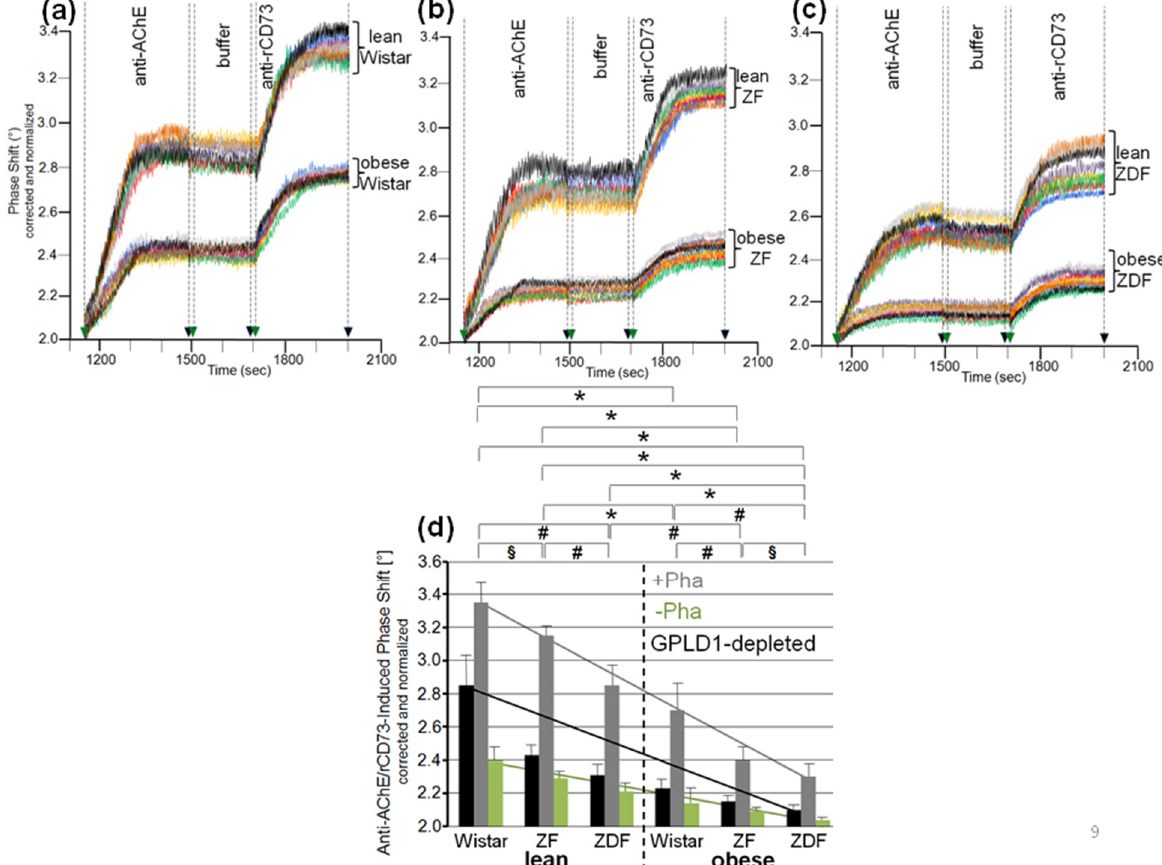
Figure 9. Differential inhibition of translocation of bAChE from micelle-like complexes to rat adipocytes by serum from metabolically deranged rats. The experiment was performed as described for Figure 8 with initial incubation (180 min) of isolated rat adipocytes with micelle-like bAChE complexes (20 volume equivalents) and serum (5 volume equivalents) that had been left untreated in the presence of Pha ( a – d ) or its absence (only d ), or that had been depleted of GPLD1 in the presence of Pha (only d ). ( a – c ) Phase shift is shown only for the injection of anti-AChE and anti-rCD73 antibodies (between 1150 and 2000 s). Each comparison was performed with the same chip and repeated three times (different preparations of micelle-like bAChE complexes) with similar results (representatives shown). ( d ) The anti-AChE and rCD73 antibody-induced phase shift between 1150 and 2000 s ( n = 8; triplicate measurements, means ± SD) obtained upon incubation of the adipocytes with micelle-like bAChE complexes and untreated serum in the absence (green bars) or presence of Pha (grey bars), or serum depleted of GPLD1 in the presence of Pha (black bars) and following transfer of bAChE as the amount of bAChE finally released is given. The comparison between the six rat groups is shown for sera treated with Pha (grey bars) only (* p ≤ 0.01, # p ≤ 0.02, § p ≤ 0.05). Each comparison was performed with the same chip and repeated two times (different preparations of micelle-like bAChE complexes) with similar results. Linear regression analysis is indicated by the lines.